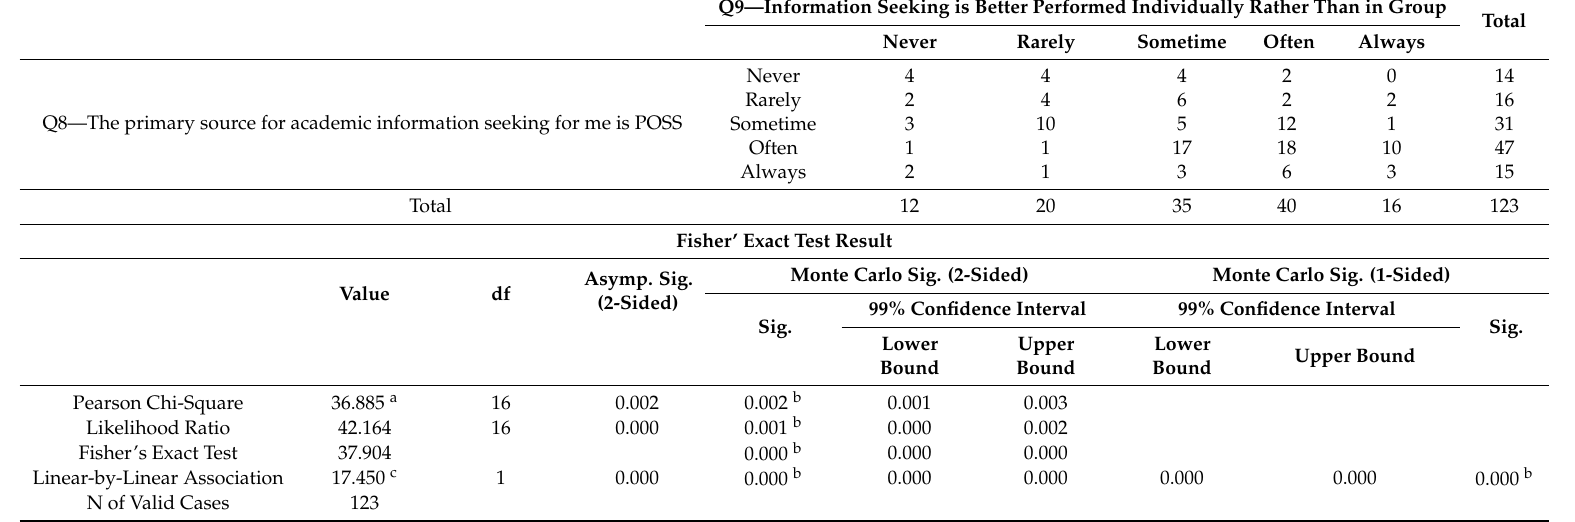
Table 6. Fisher’s Exact Test (consult POSS for IS & participate in